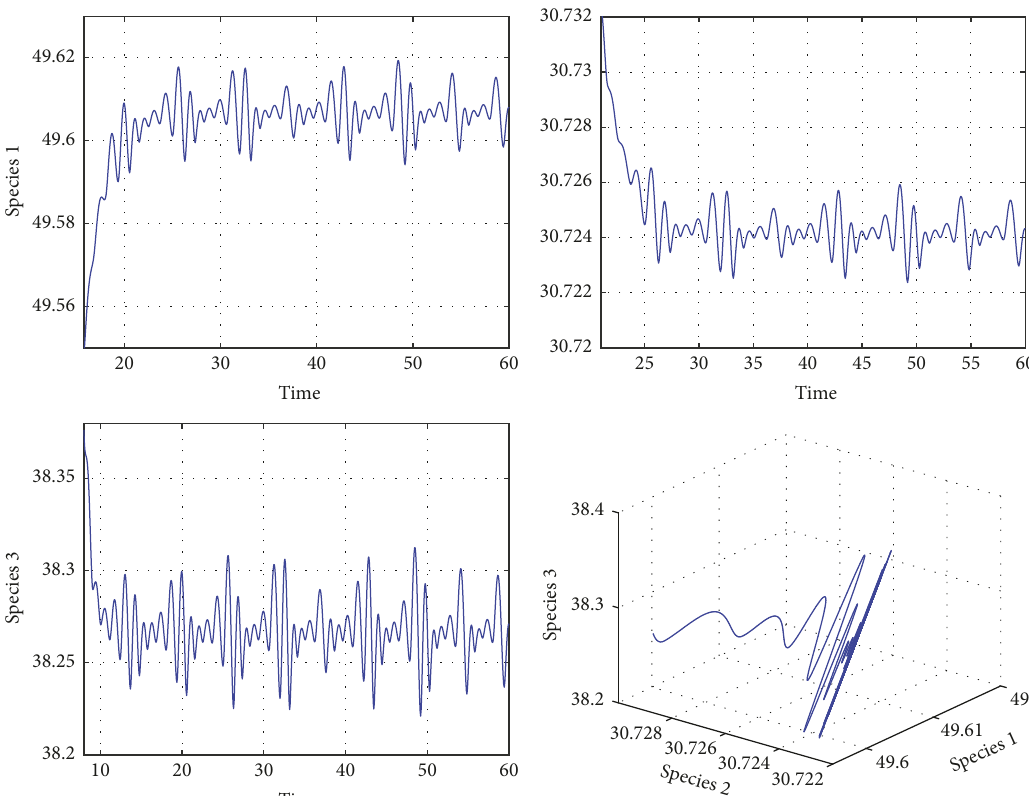
Figure 3: Dynamical behaviors and phase space trajectories of the three marine